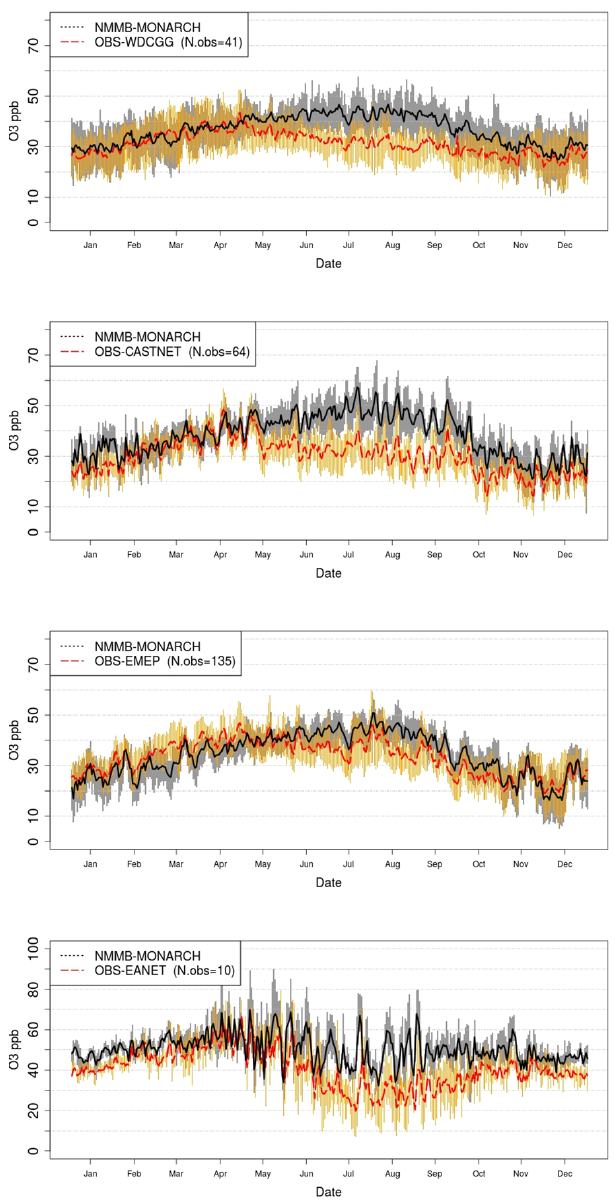
Figure 11. Time series of O 3 daily mean concentration averaged over rural WDCGG, CASTNET, EMEP and EANET stations (from top to bottom) in ppb. Observations are depicted with a solid red line and model data with a solid black line. Bars indicate the 25th–75th quartile interval for observations (orange bars) and model (gray